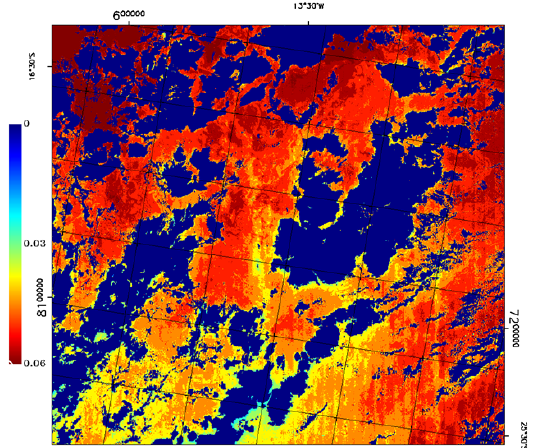
Figure 2 . QAA_V6 uses the remote sensing reflectance data to retrieve the absorption coefficient a_555 distribution map of Atlantic Ocean (Southern Hemisphere) on June 15th,